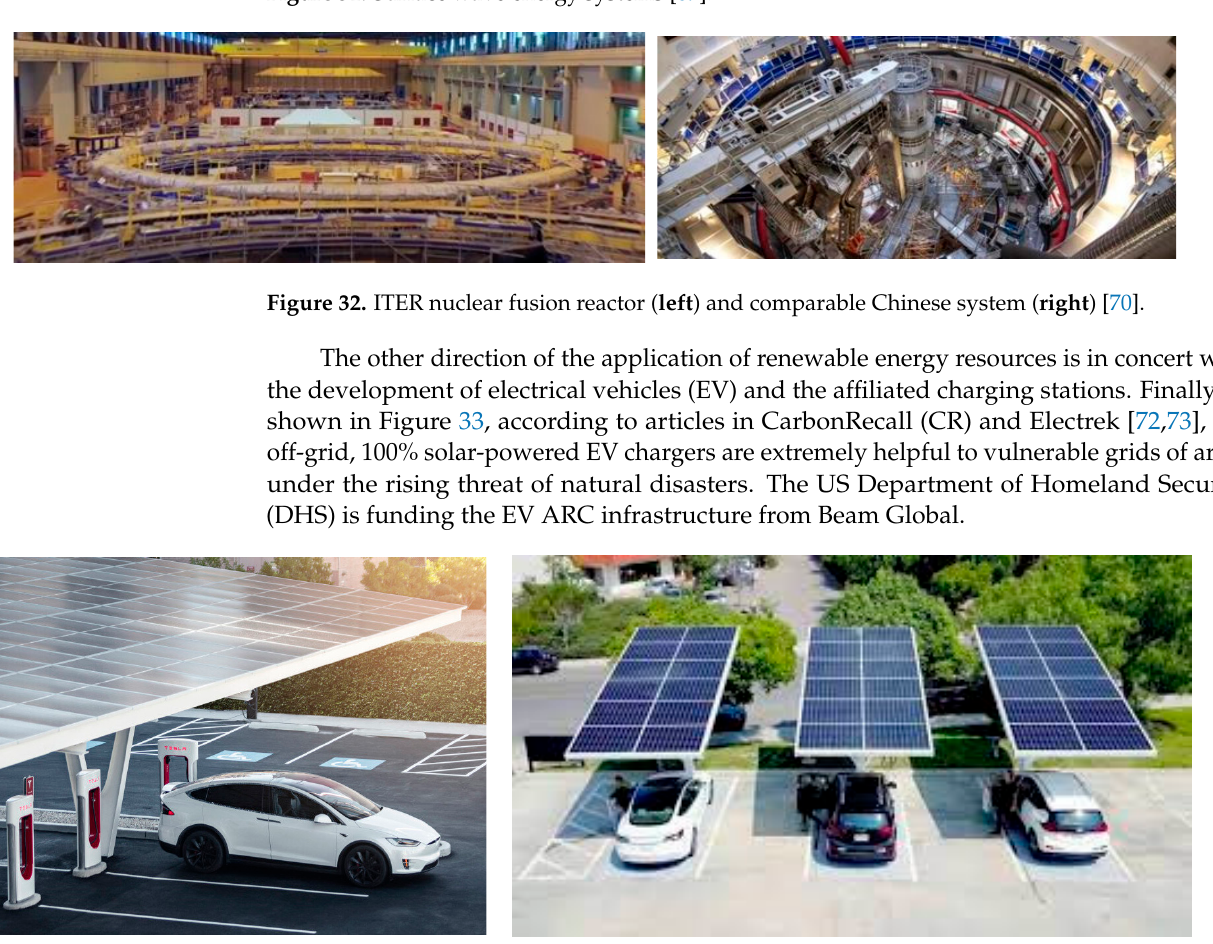
Figure 31. Surface wave energy systems [69].